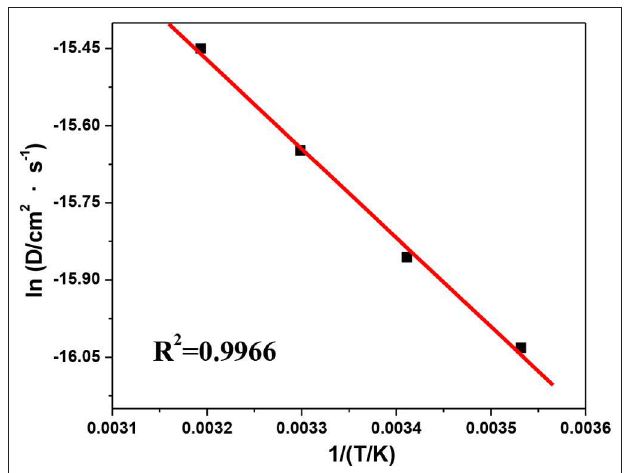
FIGURE 11 | Plot of ln D(T) vs. 1/T